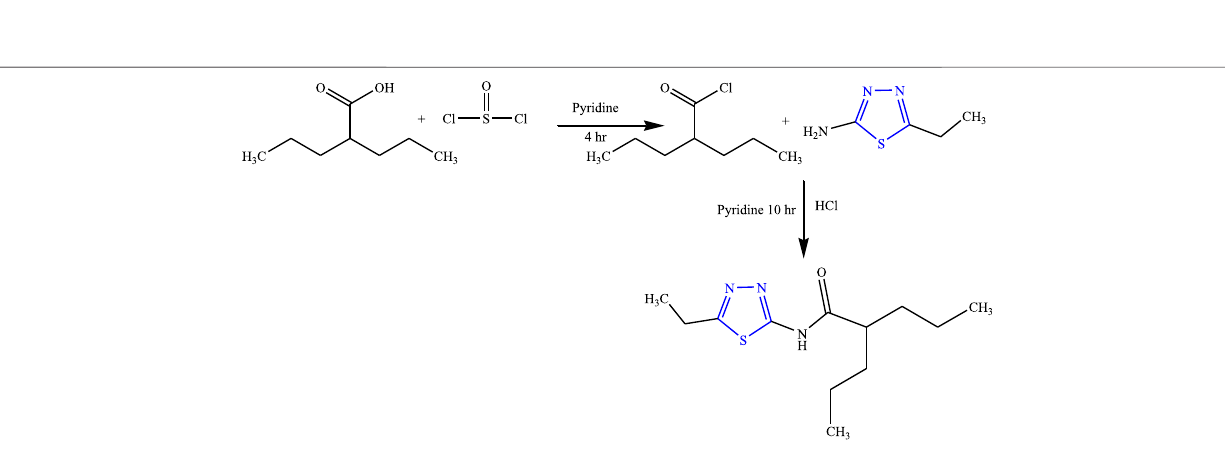
FIGURE 6 | Systematic scheme for synthesizing the valproic acid